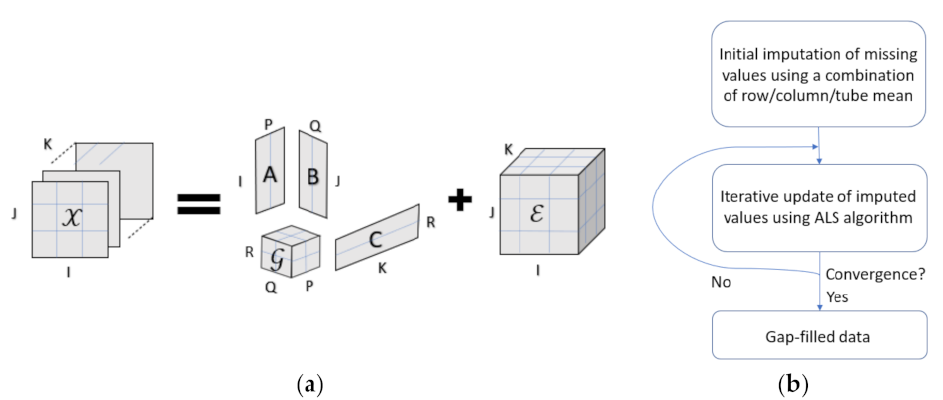
Figure 6. A visual representation of the Tucker decomposition ( a ). The third order tensor X is decomposed into a core tensor G and the loading matrices A , B , and C . The residuals are represented with E , a tensor that is the same size as X . The Tucker decomposition allows for different ranks along the tensor modes, which are denoted as P , Q, and R . The imputation process of EM Tucker is described in ( b